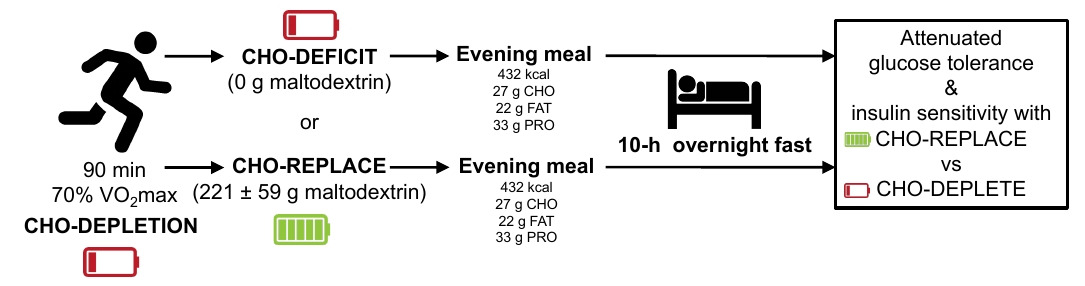
Figure 1. Schematic of the study design. CHO, carbohydrate; FAT, fat, PRO, protein; OGTT, oral glucose tolerance